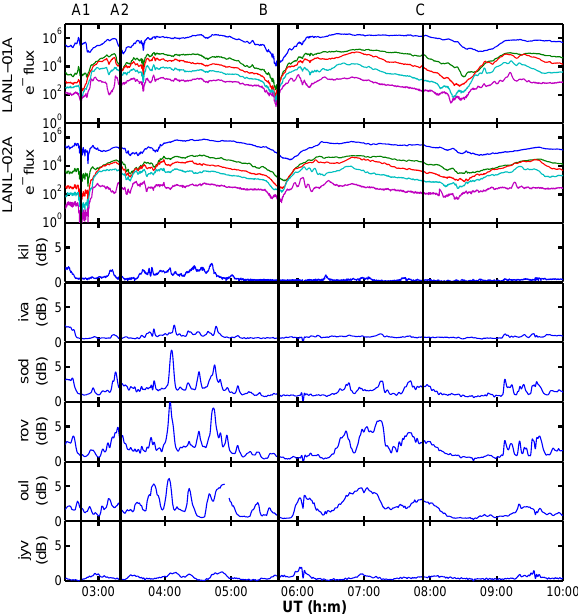
Fig. 10. Dayside observations of geostationary electron flux and riometer absorption in Finland. The vertical, solid lines show the timing of the onsets of the 4 injections. The top two panels show the electron flux (energy channels described in Fig. 3 caption) from satellites either side of the line of riometers. The bottom six panels show the morning absorption from IRIS (kil) and the SGO riome-